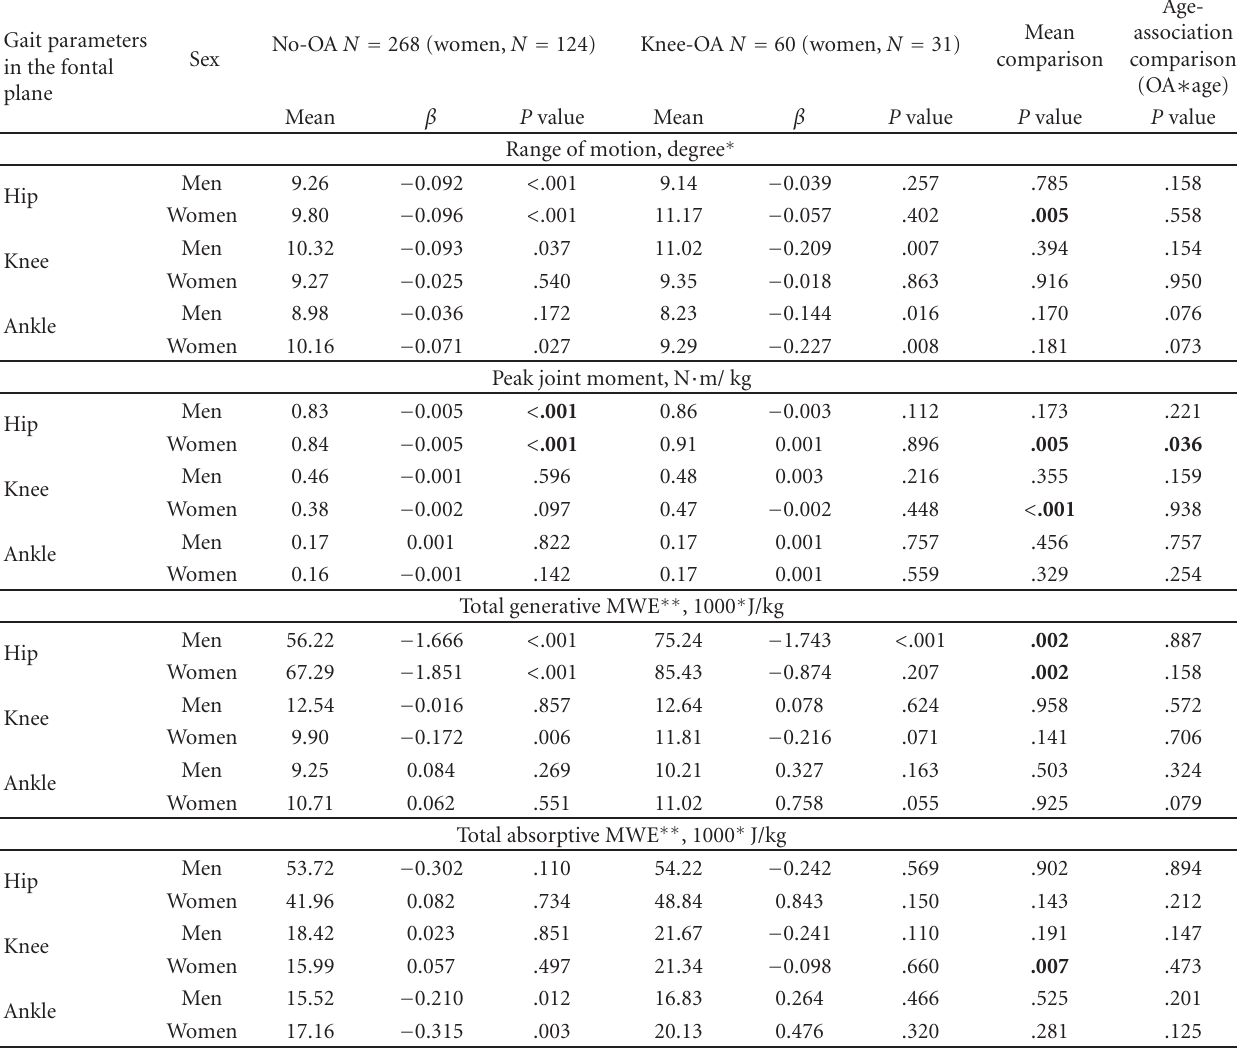
Table 4: Gait kinematic and kinetic parameters in the frontal plane for men and women with and without knee-OA.